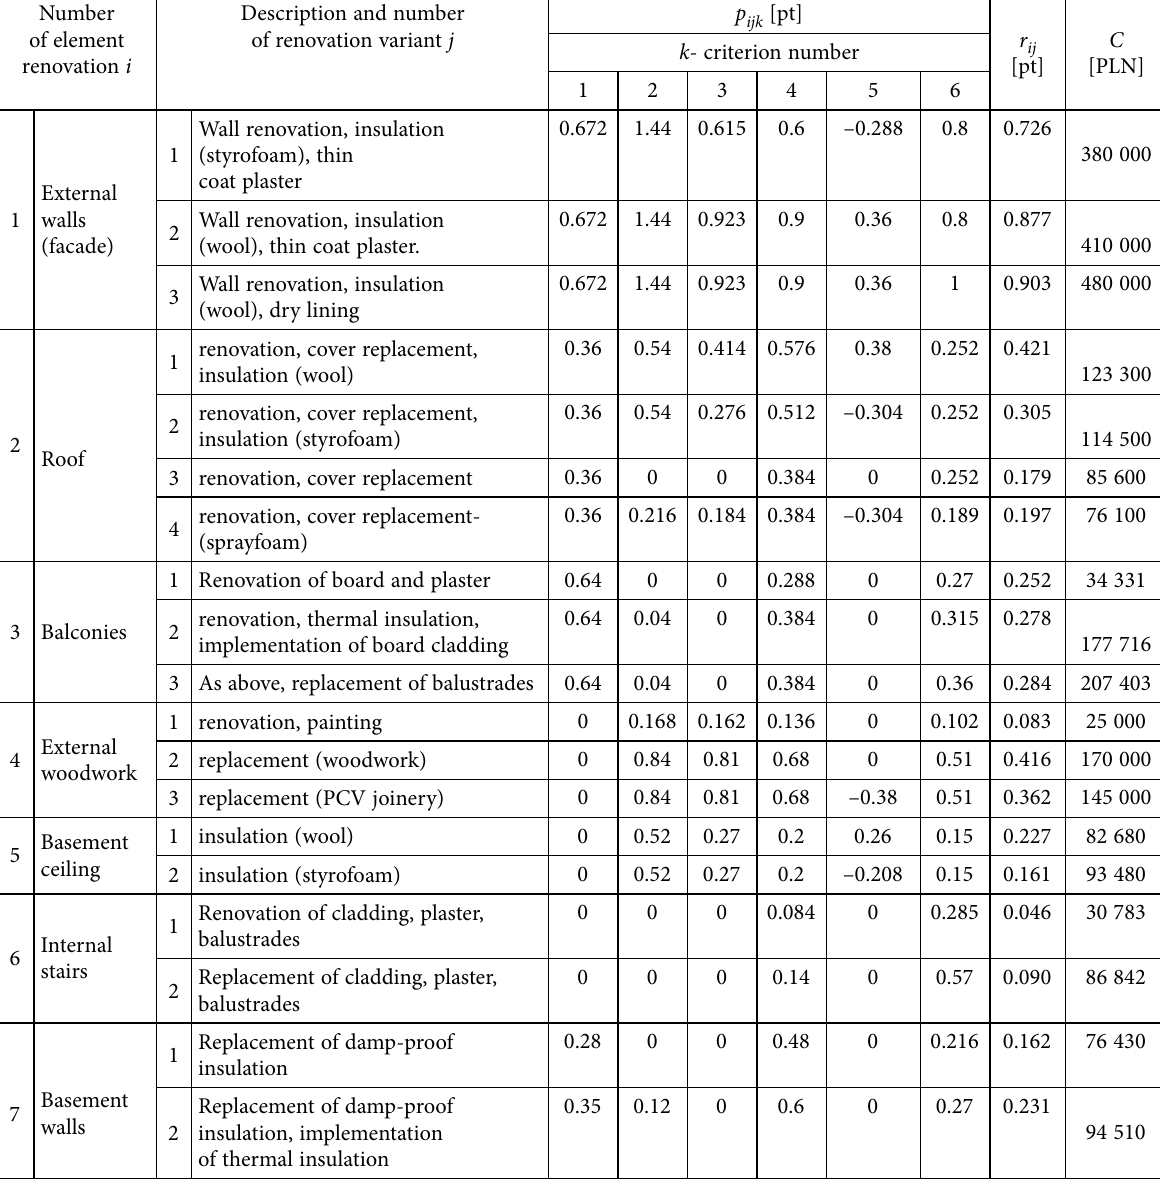
Table 2. The evaluation of growth or loss of values of criteria for the proposed variants of building